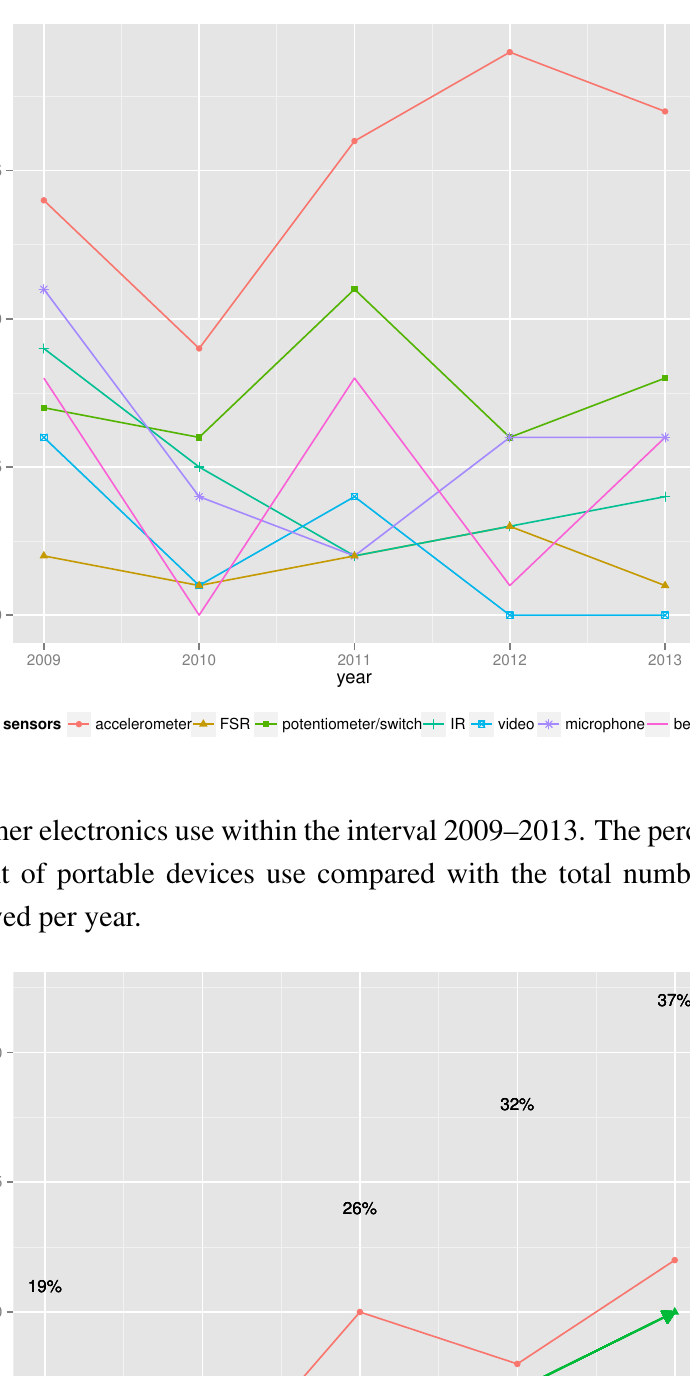
Figure 2. Trends for some sensors within the interval 2009–2013.